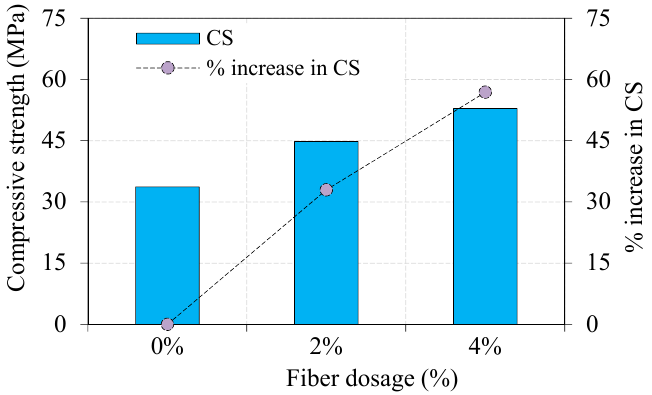
Figure 11. Compressive strength of PAFC. Table 4. Impact test